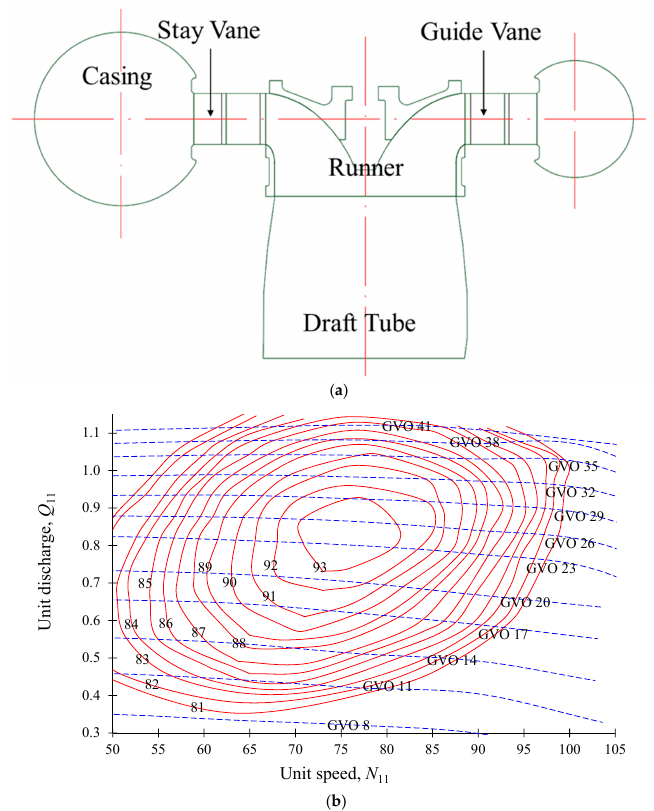
Figure 2. ( a ) Schematic view and ( b ) efficiency hill chart of the 100 MW class Francis hydro turbine by initial design.